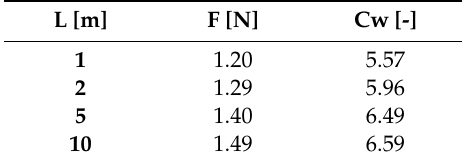
Table 2. Estimated C w values for di ff erent ice cover ranges in front of the trash